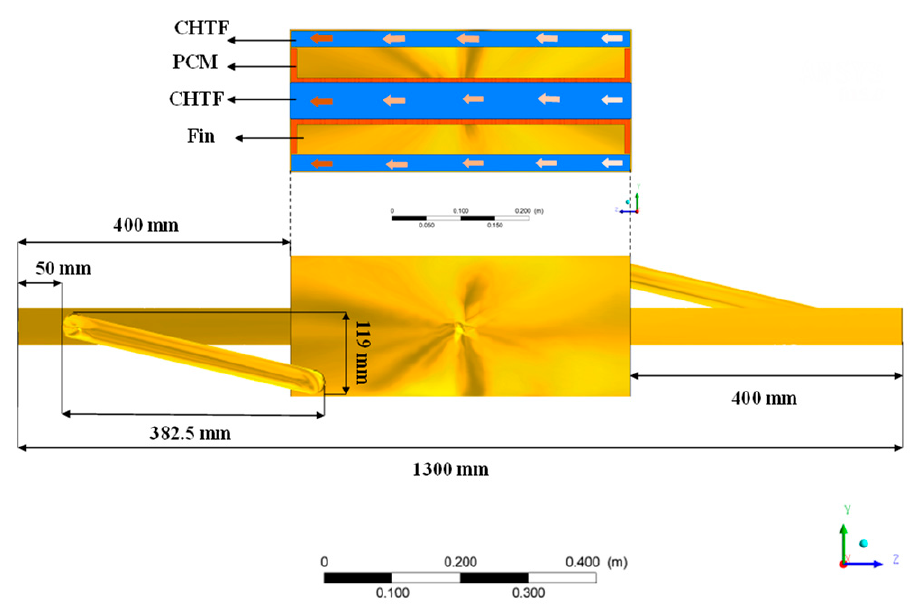
Figure 3. Side view and longitudinal section of the TTXH.